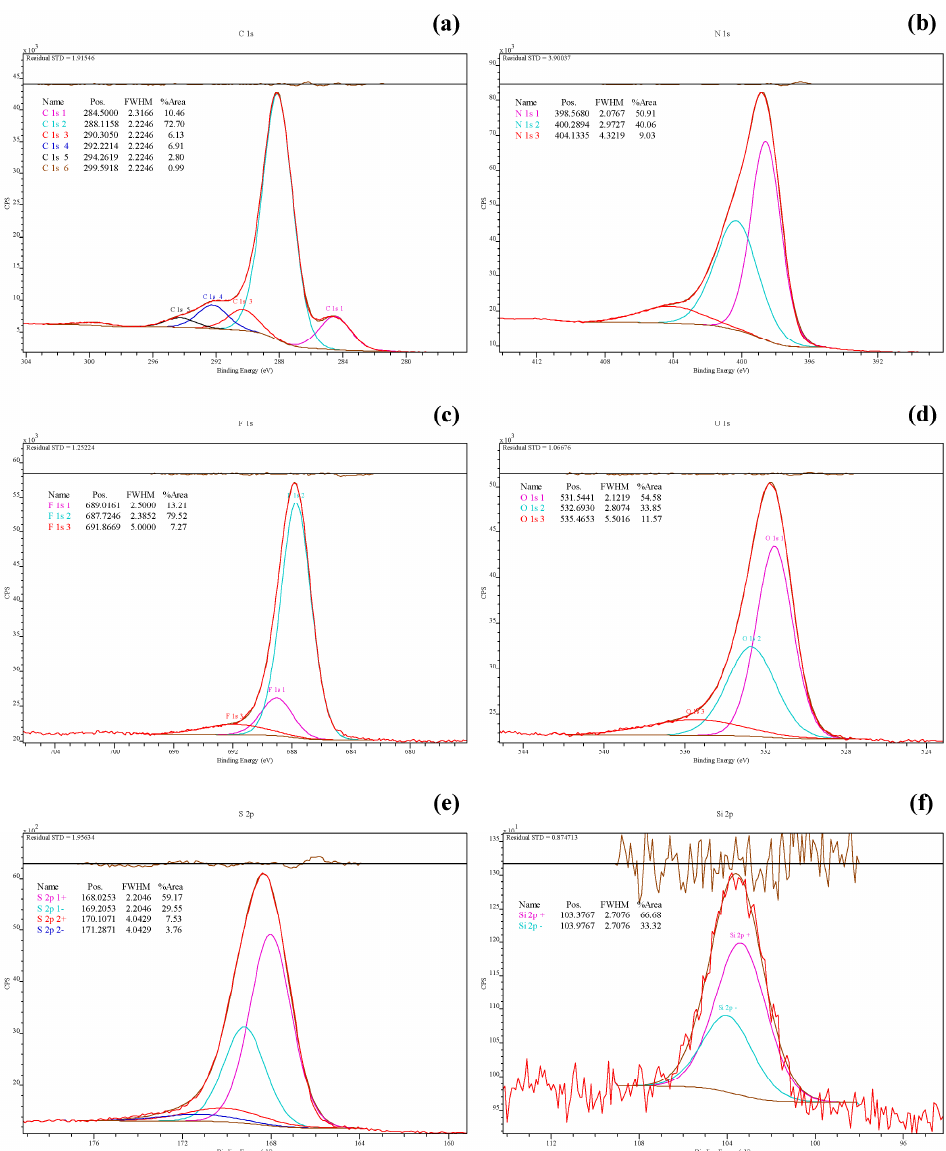
Figure 4. X-ray photoelectron spectroscopy (high-resolution regions) spectra of F,O,S-codoped g-C 3 N 4 : ( a ) C 1s, ( b ) N 1s, ( c ) F 1s, ( d ) O 1s, ( e ) S 2p, ( f ) Si 2p. The regions have been calibrated by